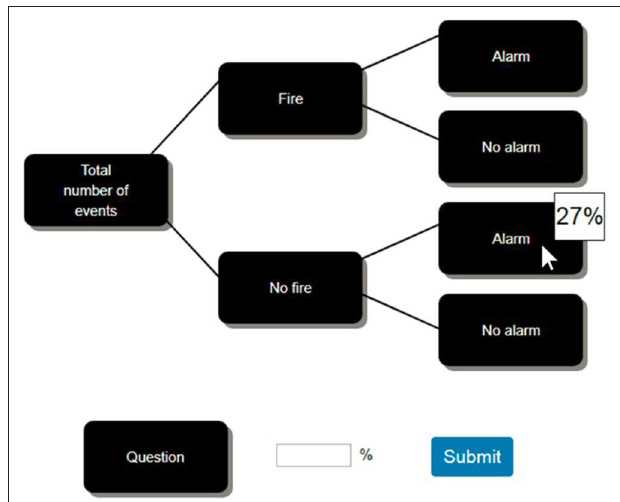
FIGURE 1 | Problem shown using a tree diagram with the probability format, where the information is hidden behind the buttons, and hovering the mouse cursor over a button reveals the information